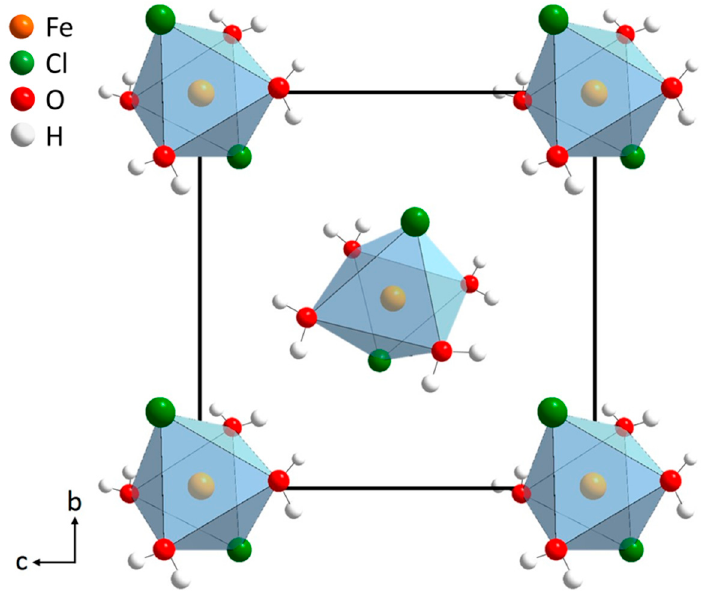
Figure 5. Crystal structure for the FeCl 2 ·4H 2 O using Diamond 3.0 software.